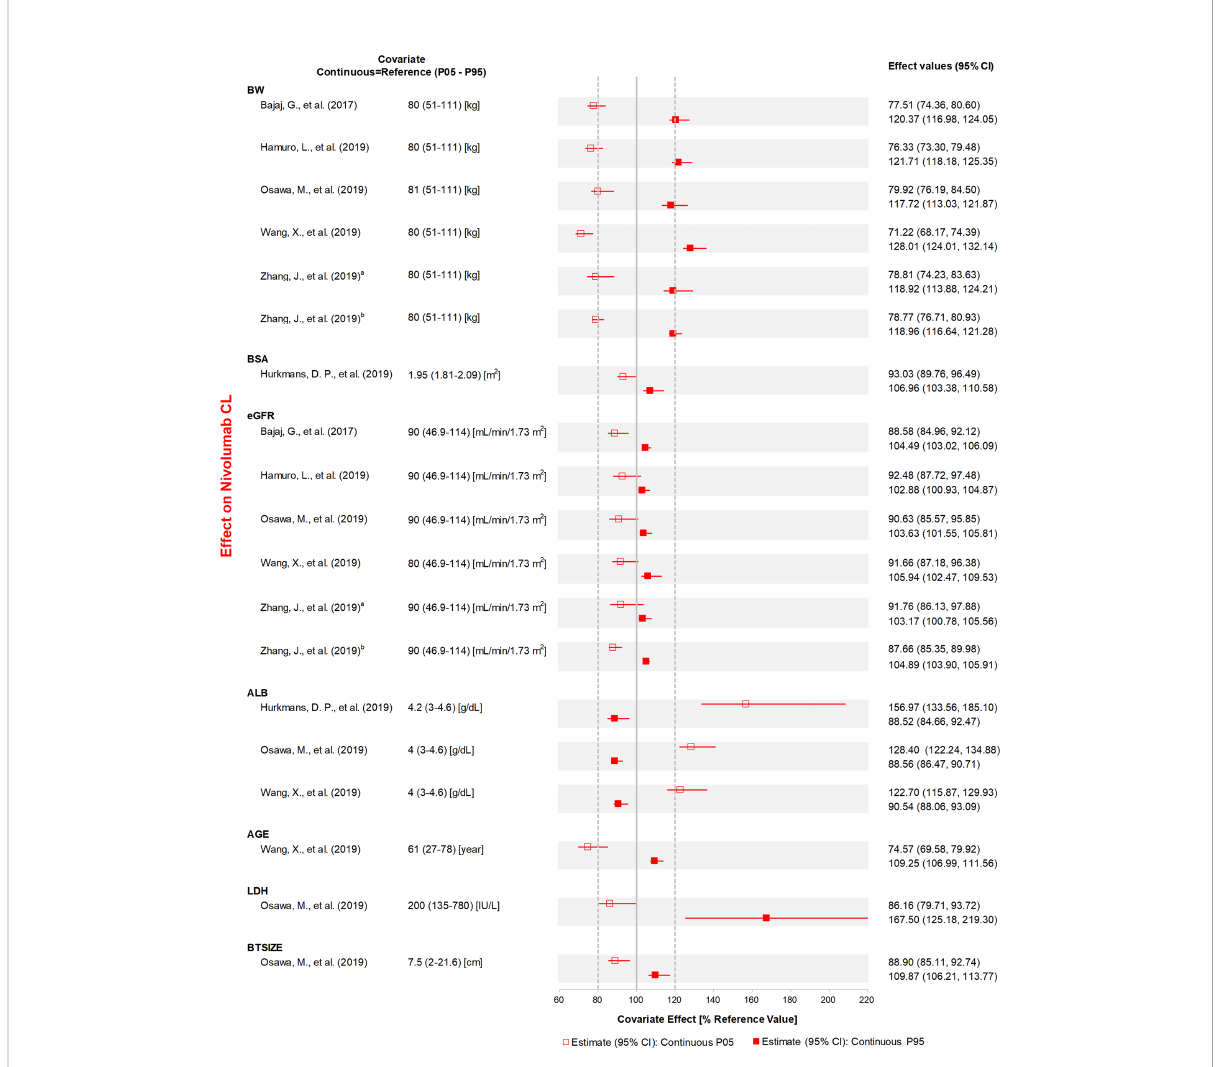
FIGURE 4 The effects of included continuous covariates on CL of nivolumab. Continuous covariate effects (95% CI) at the 5th/95th percentiles of the covariate are represented by the end of horizontal boxes (horizontal lines). The effect of each covariate for clearance is displayed by the ratio of clearance in the range of each covariate to the typical clearance value. BW, body weight; BSA, body surface area; eGFR, estimated glomerular fi ltration rate; ALB, albumin; LDH, lactate dehydrogenase; BTSIZE, baseline tumor size described by the sum of long diameters of target tumor lesions; P05, 5th percentile; P95, 95th percentile. a Reference (31), b Reference